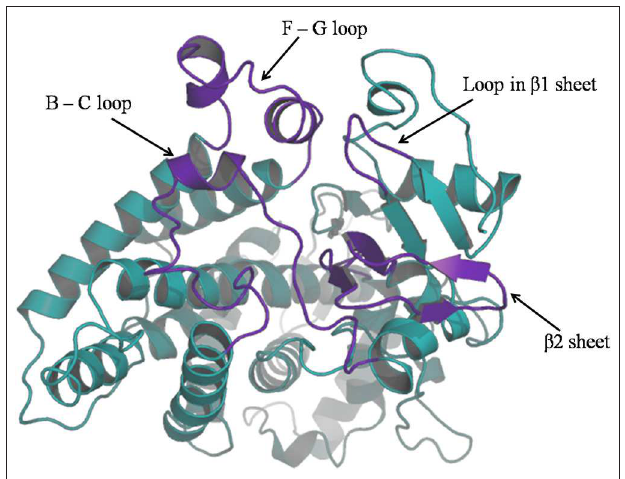
FIGURE 6 | The ribbon diagram of CYP2D6; channel entrance is highlighted in